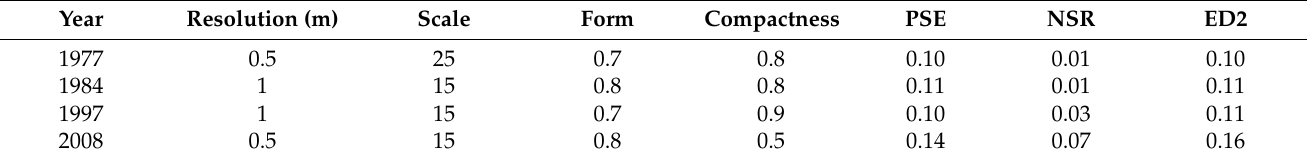
Table 4. Parameters of the final segmentations used in each. The segmentation accuracy indices are shown. PSE: potential segmentation error; NSR: number-of-segments ratio; ED2: Euclidean distance 2.